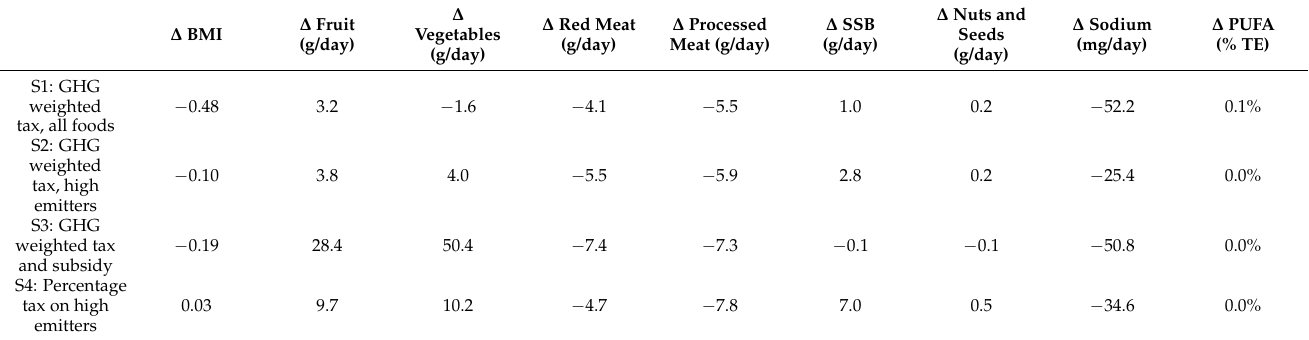
Table 1. Population weighted change in BMI and dietary risk factors used for modelling of